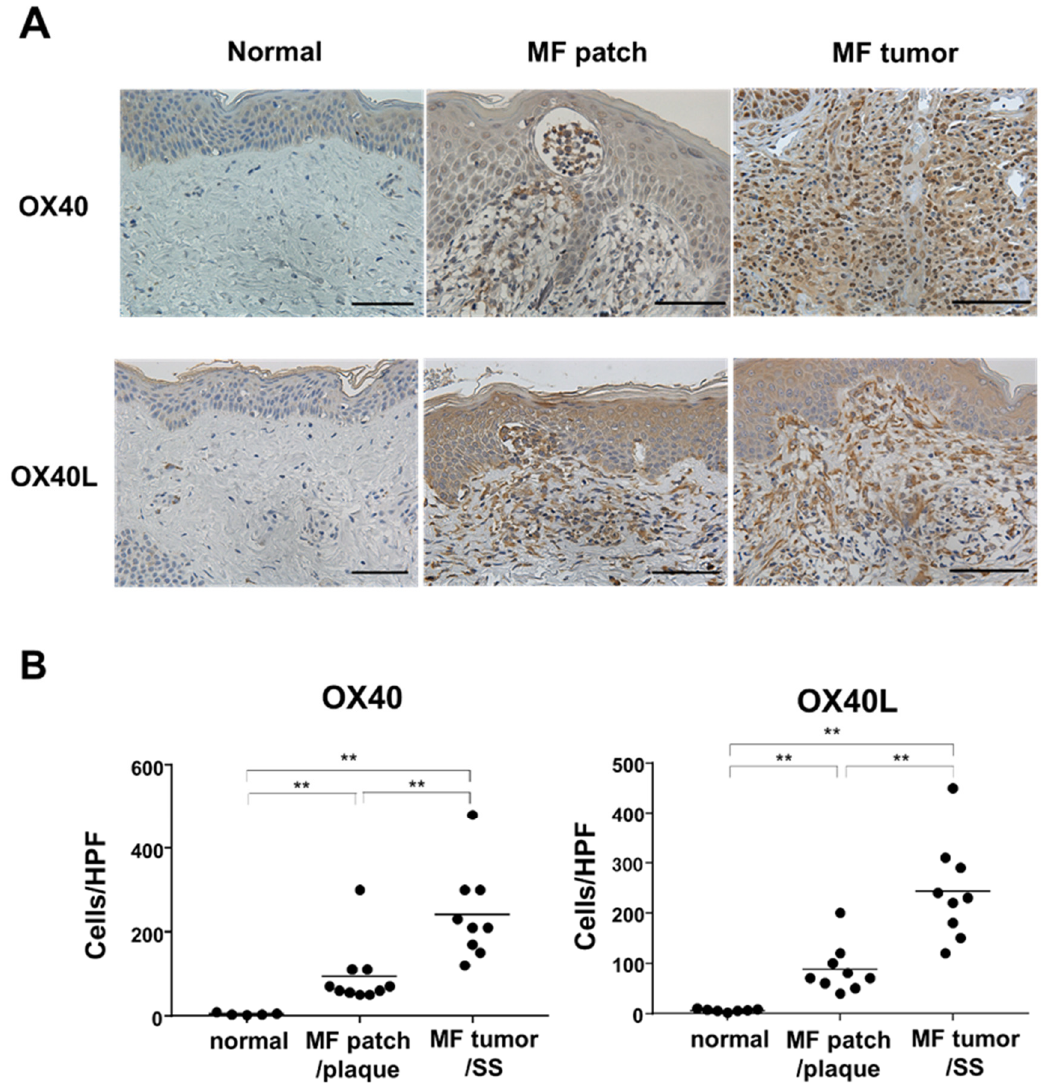
Figure 2. OX40 and OX40L expression in lesional skin of MF/SS was determined by immunohistochemistry (original magnification × 400, scale bar = 100 µ m). ( A ) Representative results are shown. ( B ) Counts of OX40 and OX40L-positive cells. Ten cases of patch/plaque MF, nine cases of tumor MF/SS, and seven cases of healthy subjects. ** p < 0.01.